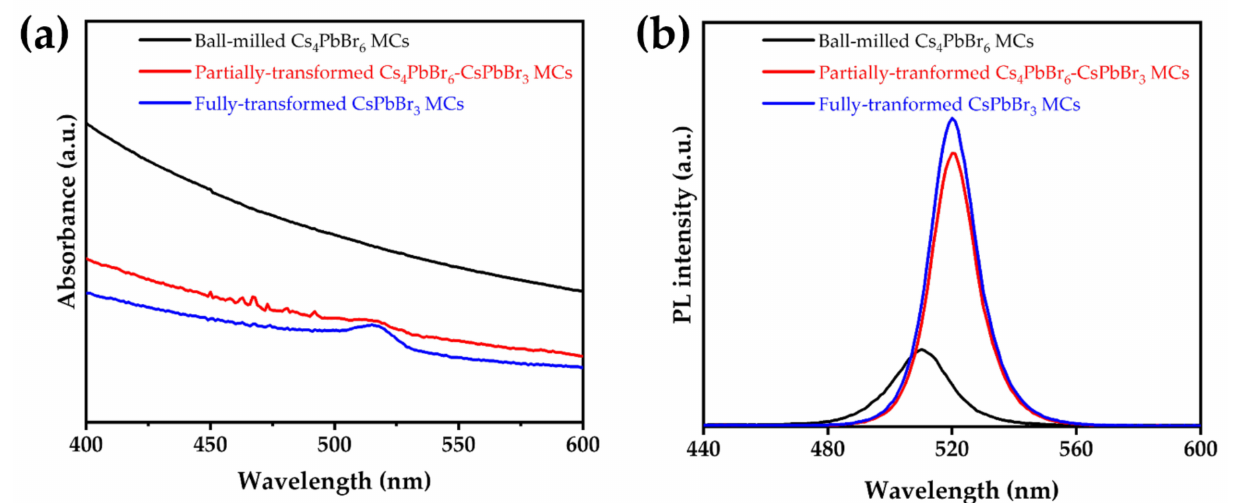
Figure 4. ( a ) Absorption and ( b ) PL spectra of the ball-milled Cs 4 PbBr 6 MCs, partially transformed Cs 4 PbBr 6 –CsPbBr 3 MCs, and fully transformed CsPbBr 3